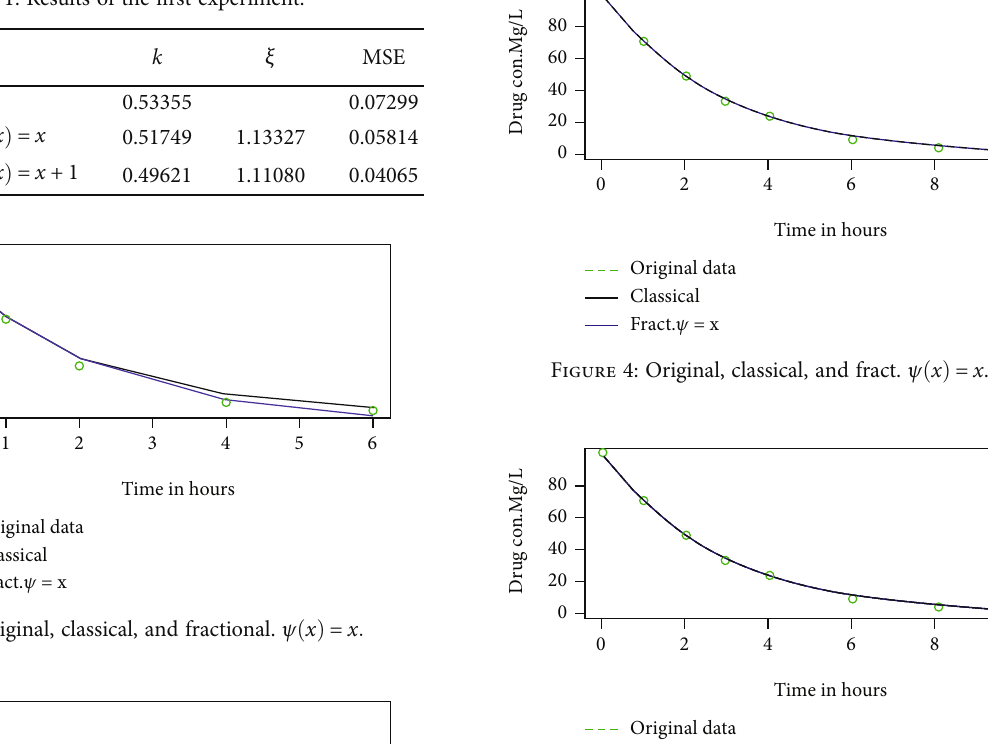
Table 1: Results of the fi rst experiment.